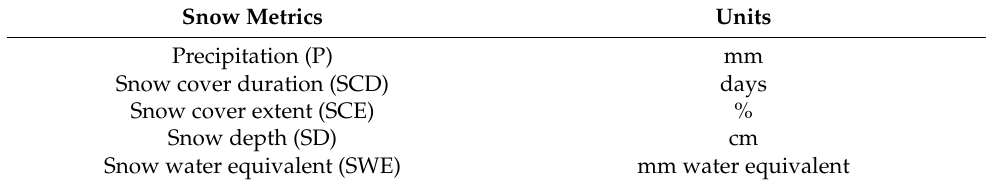
Table 1. Snow metrics used to analyse historical and projected changes in snow cover. Snow